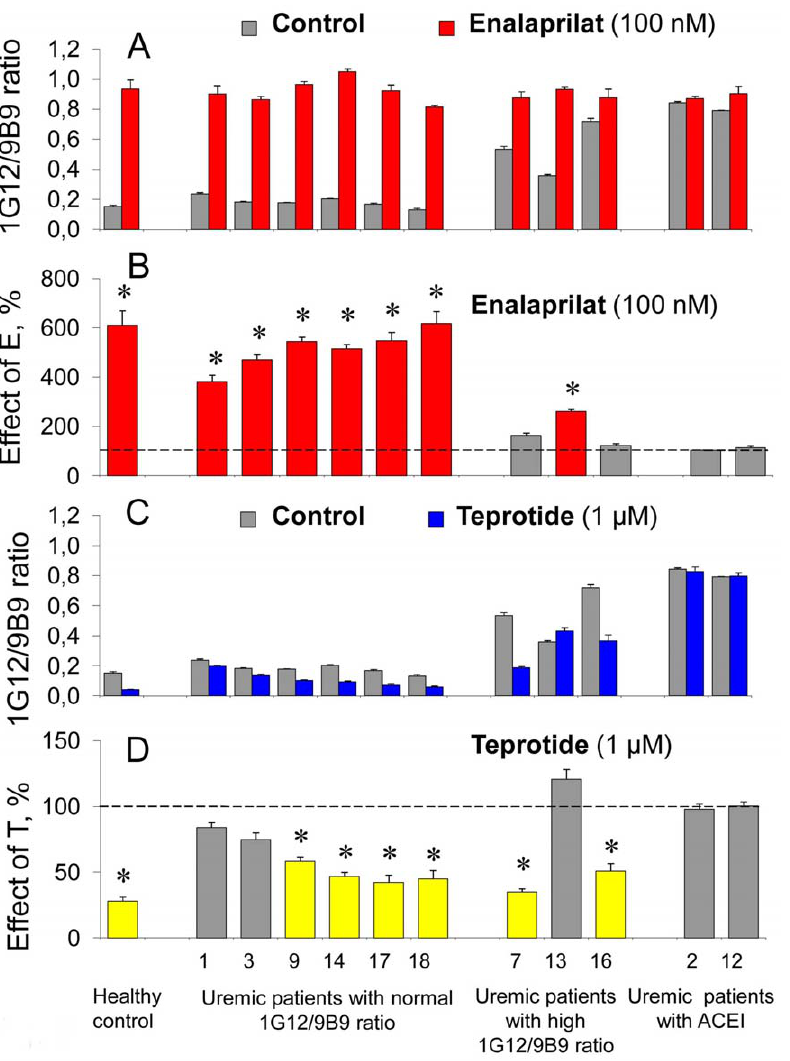
Figure 5. Effect of ACE inhibitors on the local conformation of blood ACE in uremia. A . The ratio of ACE activities precipitated from the citrated plasma of uremic patients by mAbs 1G12 and 9B9 (1G12/9B9 ratio) and from pooled plasma from healthy volunteers in the presence of enalaprilat (100 nM) – red bars and without the inhibitor – grey bars. B . The data presented on Fig. 5A were also expressed as a percentage of the effect of enalaprilat on the values of 1G12/9B9 ratio for different patients. The red columns show those mAbs for which enalaprilat effect (increase of mAb binding) exceeded 20%. C . The ratio of ACE activities precipitated from the citrated plasma of uremic patients by mAbs 1G12 and 9B9 (1G12/ 9B9 ratio) and from pooled plasma from healthy volunteers in the presence of teprotide (1 m M) – blue bars and without the inhibitor – grey bars. D . The data presented on Fig. 5C were also expressed as a percentage of the effect of teprotide on the values of 1G12/9B9 ratio for different patients. The yellow columns show those mAbs for which teprotide effect (decrease of mAb binding) exceeded 20%. All other terms and conditions – as in Figure 1. Data are mean 6 SD of 3 independent experiments (each in duplicates). *, p , 0.05 in comparison with mean value obtained without